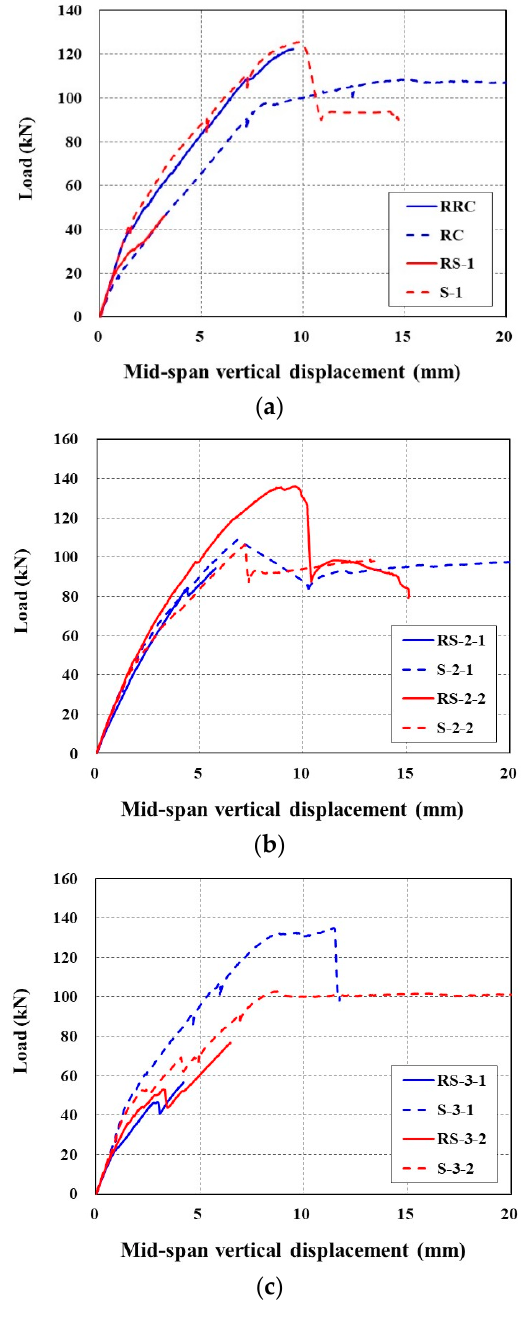
Figure 21. Comparison of load-displacement curves of strengthened specimens with re-strengthened specimens: ( a ) RRC and RS-1; ( b ) RS-2 series; and ( c ) RS-3 series.